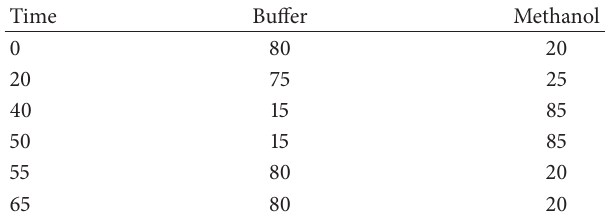
Table 3: Gradient